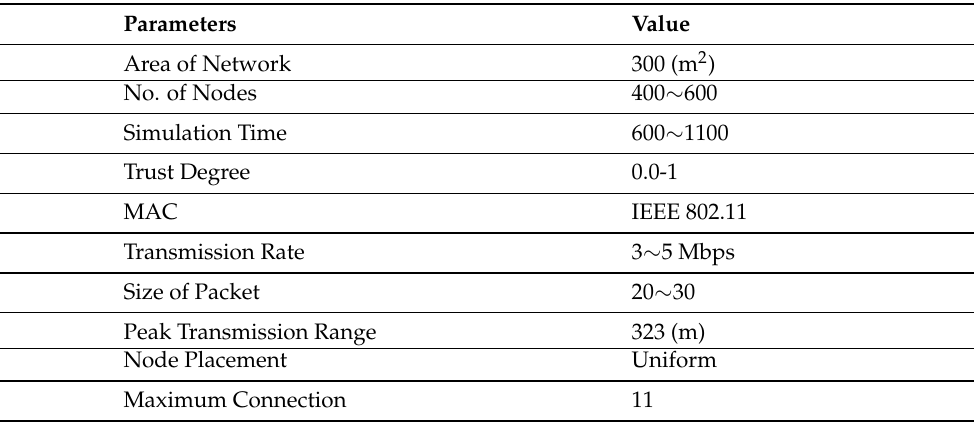
Table 2. Parameters and simulation